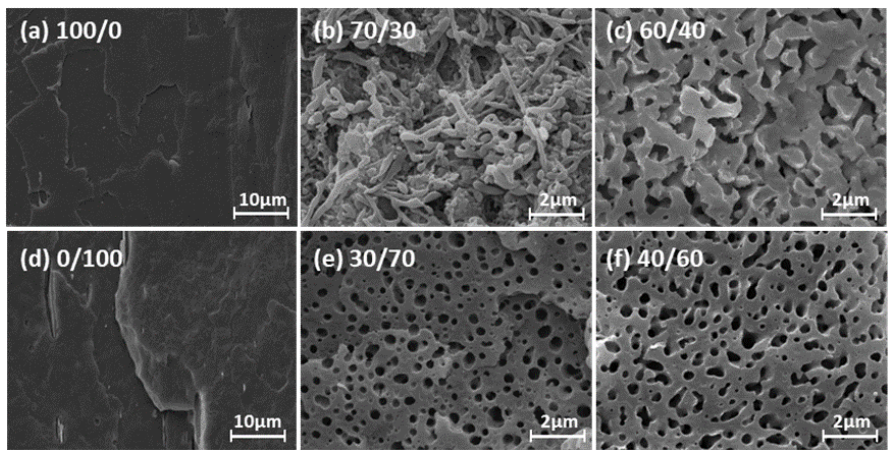
Figure 6. SEM micrographs of fractured surfaces of PLA/PHBV blends at different compositions: 100/0 ( a ), 70/30 ( b ), 60/40( c ), 0/100 ( d ), 30/70 ( e ), and 40/60 ( f ).